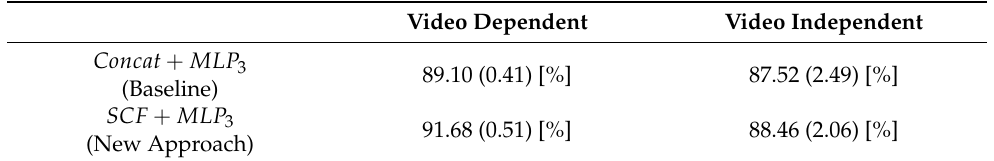
Table 5. Audiovisual results using the AVA-ActiveSpeaker videos with respect to Mean Accuracy (Standard